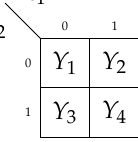
Figure 5. Maximum codes of collections of outputs.